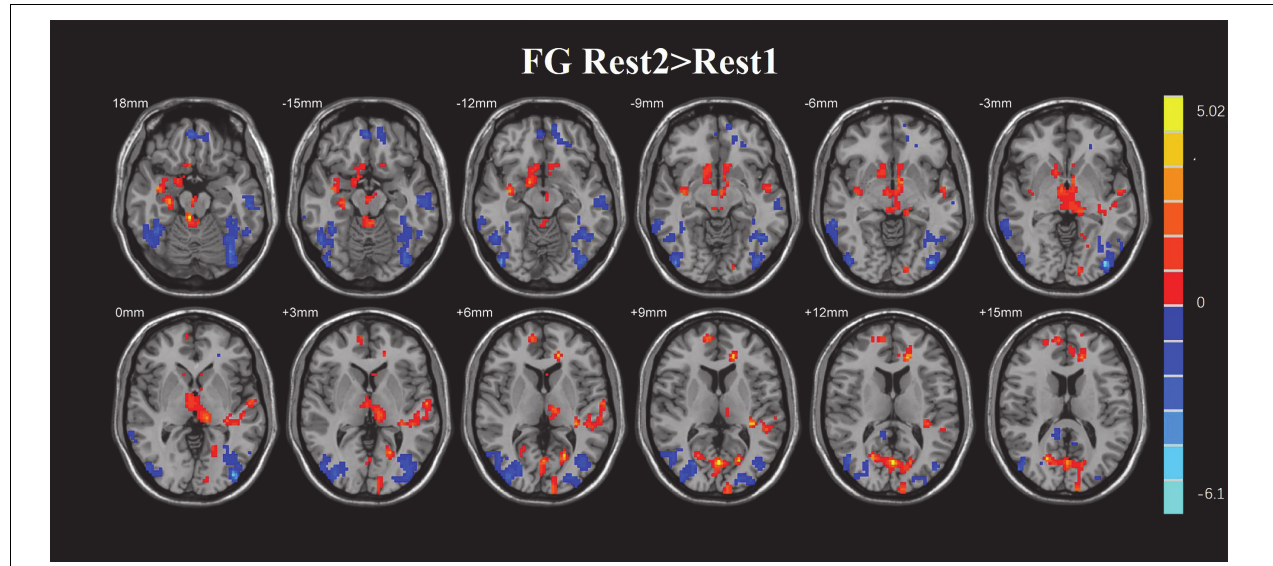
FIGURE 8 | Regions with altered ReHo score in the experimental group after rtfMRI-NF training. The ReHo score of increased in the FG was observed in the right hippocampus, right parahippocampal gyrus, left insula, right superior frontal gyrus, left anterior cingulate gyrus, left inferior occipital gyrus, left inferior frontal, and right middle frontal gyrus. The regions of decreased ReHo score were found in the right cingulum, left cingulum, and left middle occipital gyrus (AlphaSim corrected p <